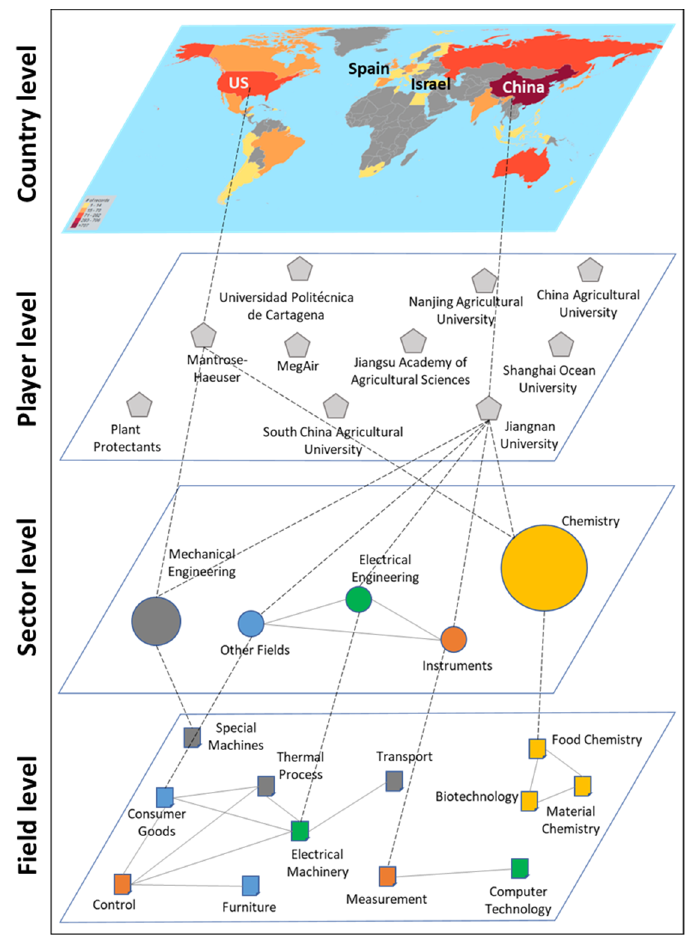
Figure 9. A multi-layered network within an innovation ecosystem.